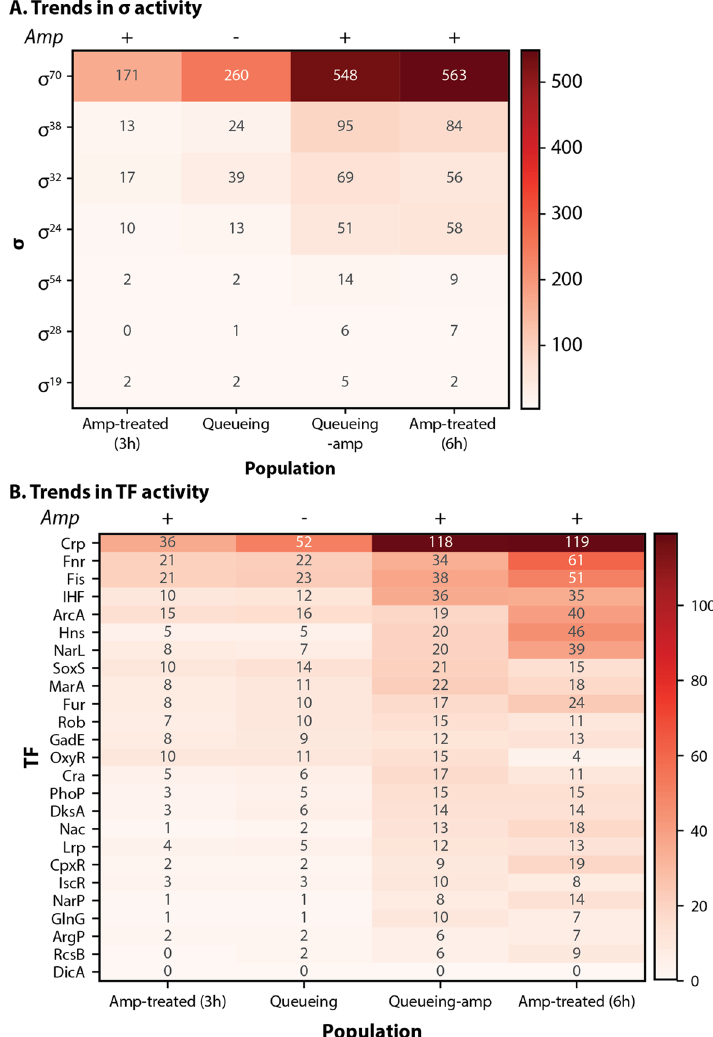
Figure 6. Proteolytic queueing and ampicillin treatment affect specific regulatory proteins in E. coli . Changes in gene expression compared to stationary phase (adjusted p < 0.1; with > twofold change) for each population with/without queueing and/or ampicillin. Not shown are changes in gene expression present in the untreated population. The amp treated population was sequenced after three (3 h) and six (6 h) hours of ampicillin treatment. ( A ) Changes in gene expression mapped to sigma factors (σ) for each population. Genes transcribed by multiple sigma factors were counted for each sigma factor. ( B ) Changes in gene expression mapped to transcription factors (TFs) for each population. Genes transcribed by multiple TFs were counted for each